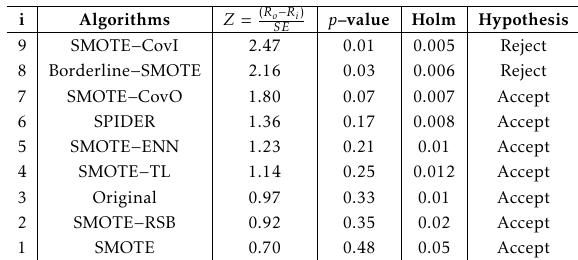
Table 4. Holms test with α = 0 . 05 , taking ADASYN as a control